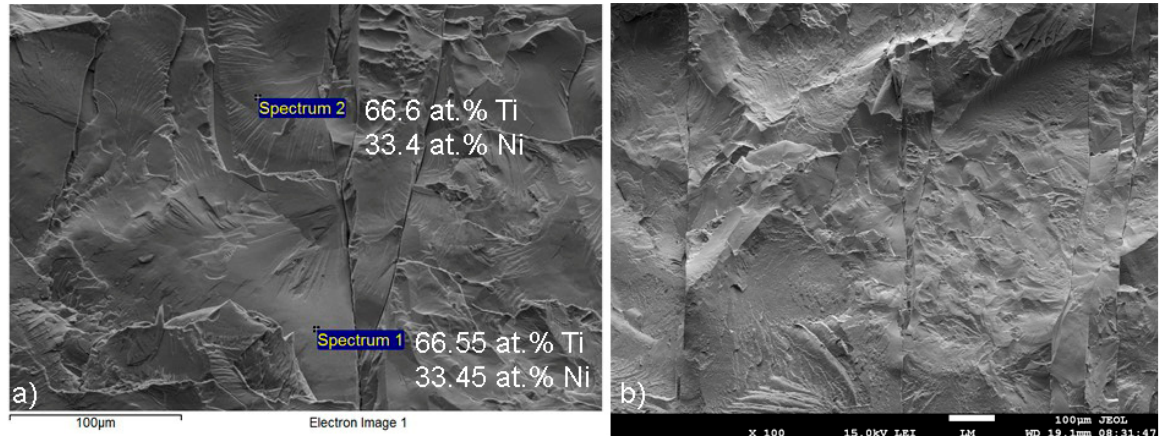
Figure 15. Morphology of the fracture surface at the interface of Ti Grade 2 and weld metal ( a , b